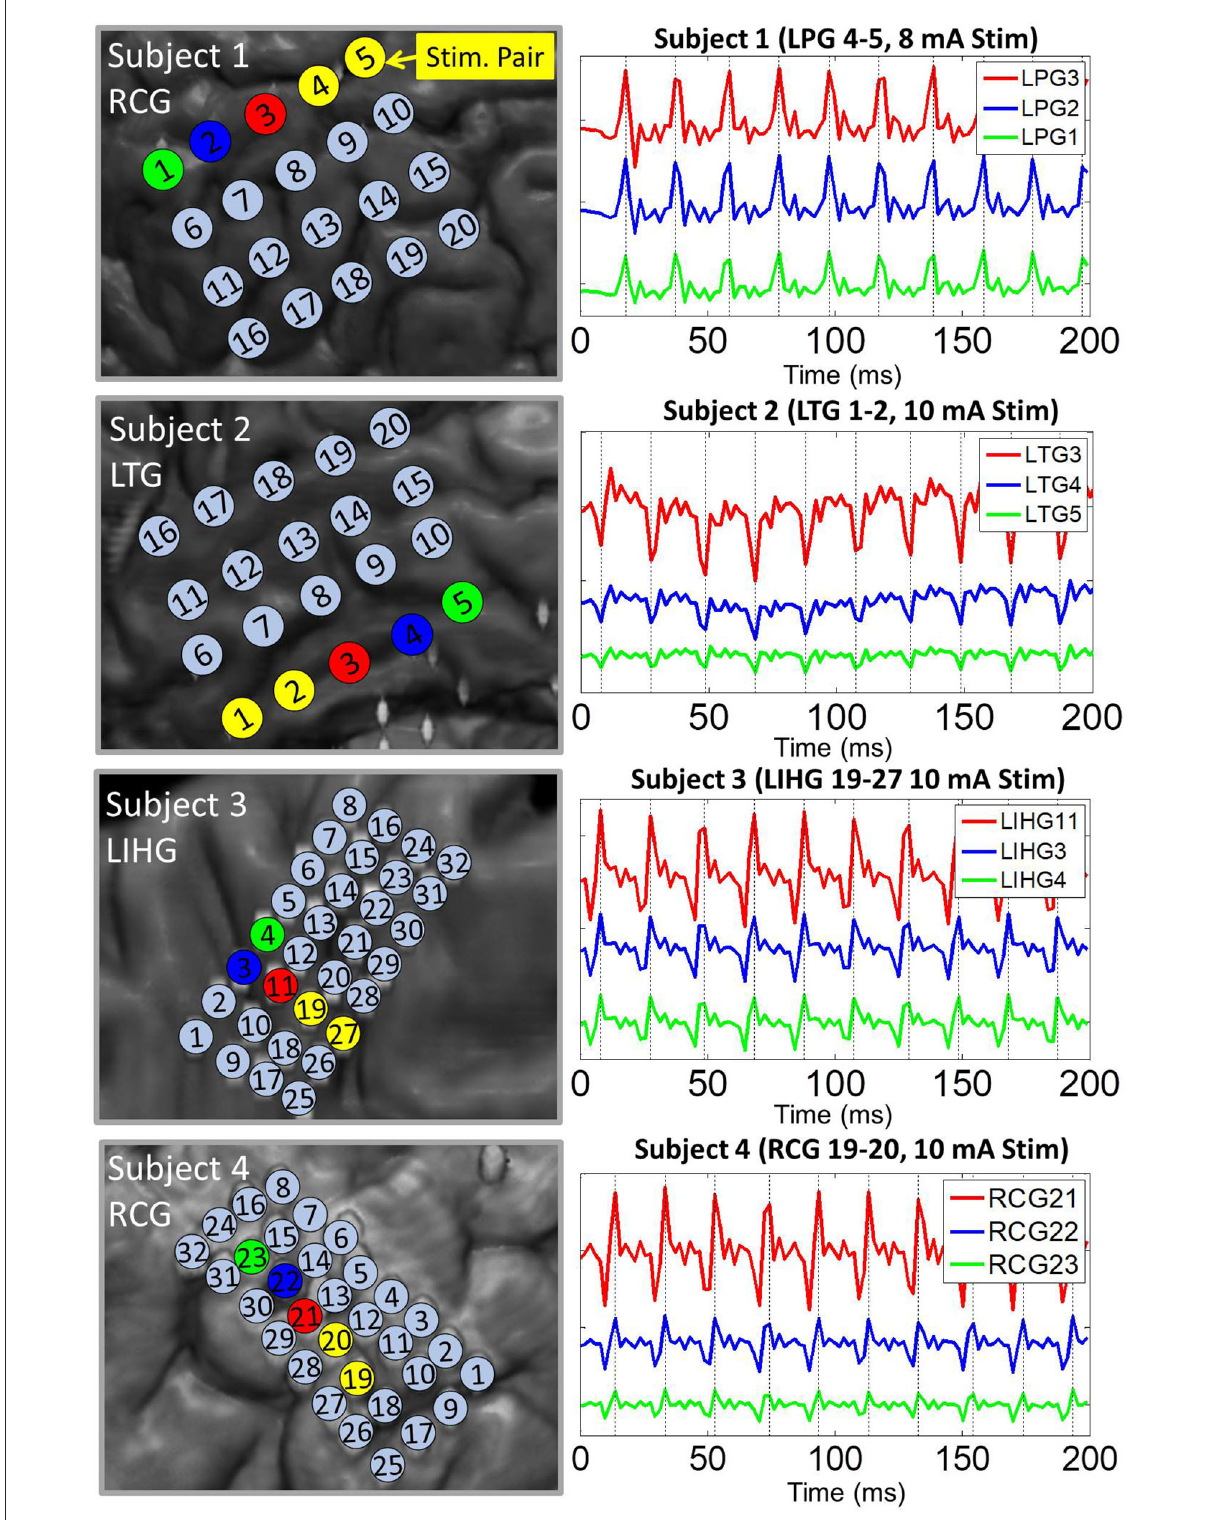
FIGURE3 Representative examples of pulse response phase-locking in all 4 subjects. (Left) Insets of co-registration images, with color-coded electrodes lying in the direction of strongest artifact (co-linear with the dipole moment). (Right) ECoG data high-passed at 1.5 Hz with colors matched to the corresponding electrode. Artifact peaks/troughs, marked by vertical lines, on these electrodes are within 2 ms (1 sample) of each other. Pulse responses occur every 20 ms (50 Hz pulse train frequency). The artifact amplitude decreases with distance from the stimulation